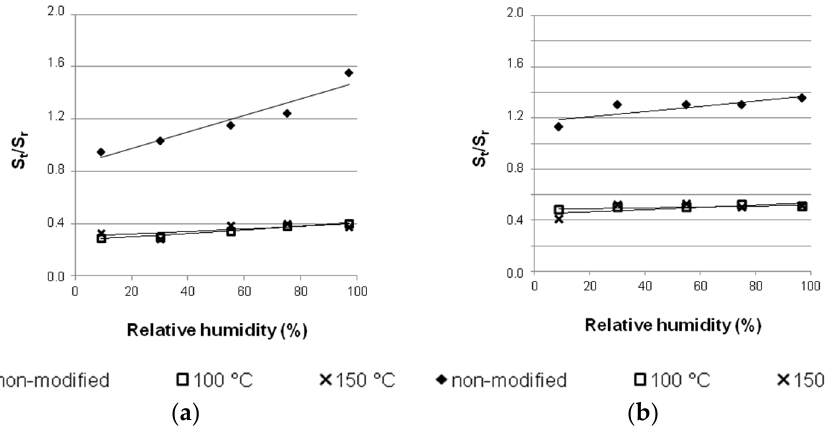
Figure 6. S t /S r ratio of ( a ) iroko and ( b ) tauari wood before and after thermo-mechanical modification, depending on relative humidity of air.